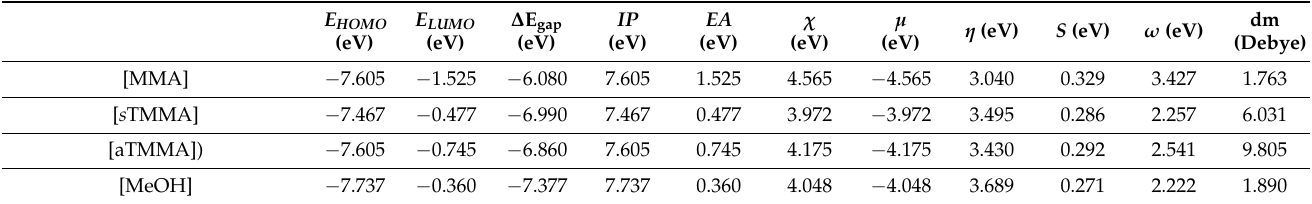
Table 3. HOMO-LUMO gap ( ∆ E gap ), ionization potential (IP), electron affinity (EA), electronega- tivity ( χ ), chemical potential ( µ ), hardness ( η ), softness ( S ), electrophilicity index ( ω ) and dipole moments (dm) of MMA; sTMMA; aTMMA and their complexes with alcohols (methanol; ethanol and isopropanol) at the B3LYP/6-311++G(d,p) level of theory. (gas phase). ∆ E E HOMO E LUMO IP gap (eV) (eV) (eV) (eV) −